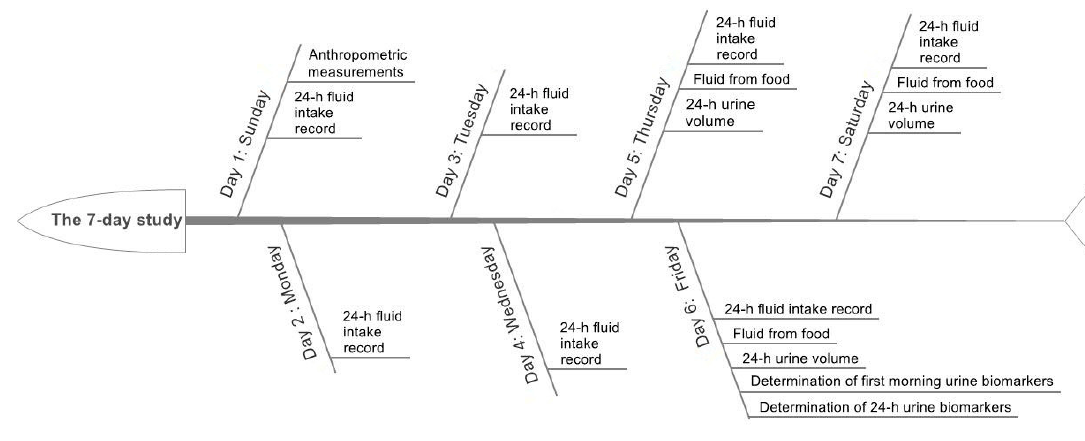
Figure 1. The study procedure.